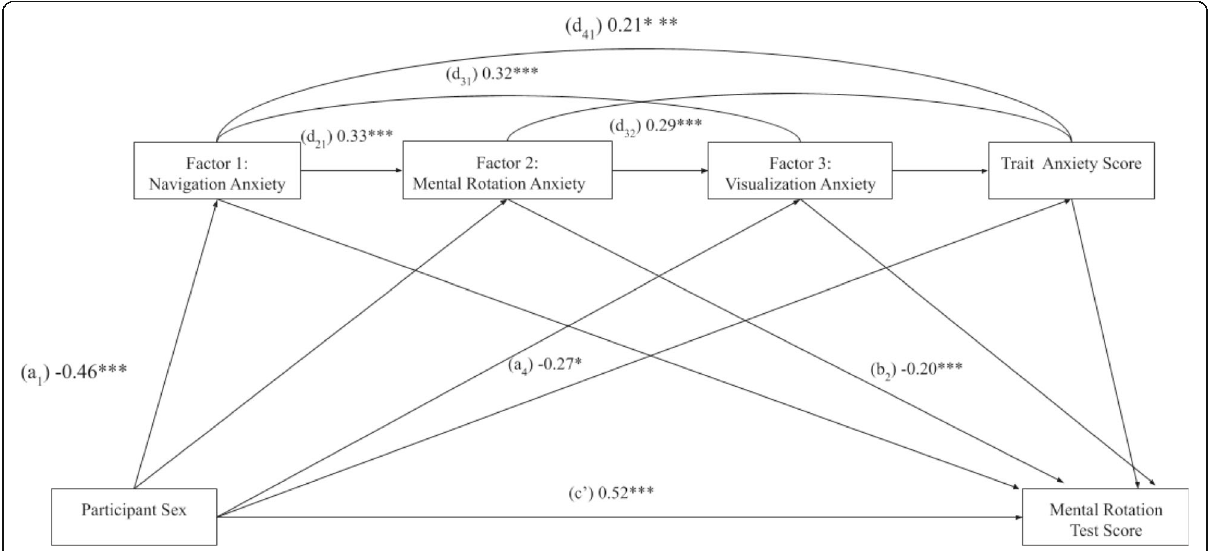
Fig. 4 Mediation of the relation between participant sex and mental rotation score including factors identified through exploratory factor analysis and trait anxiety